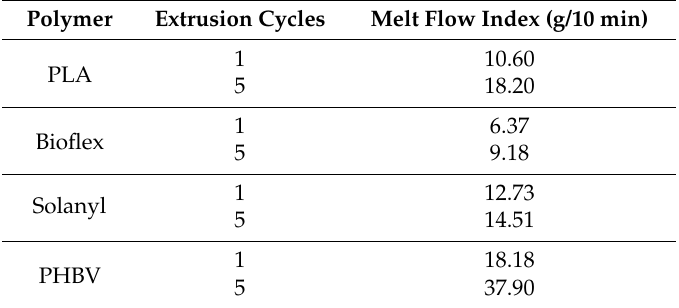
Table 4. Melt flow index of virgin and recycled biopolymers.